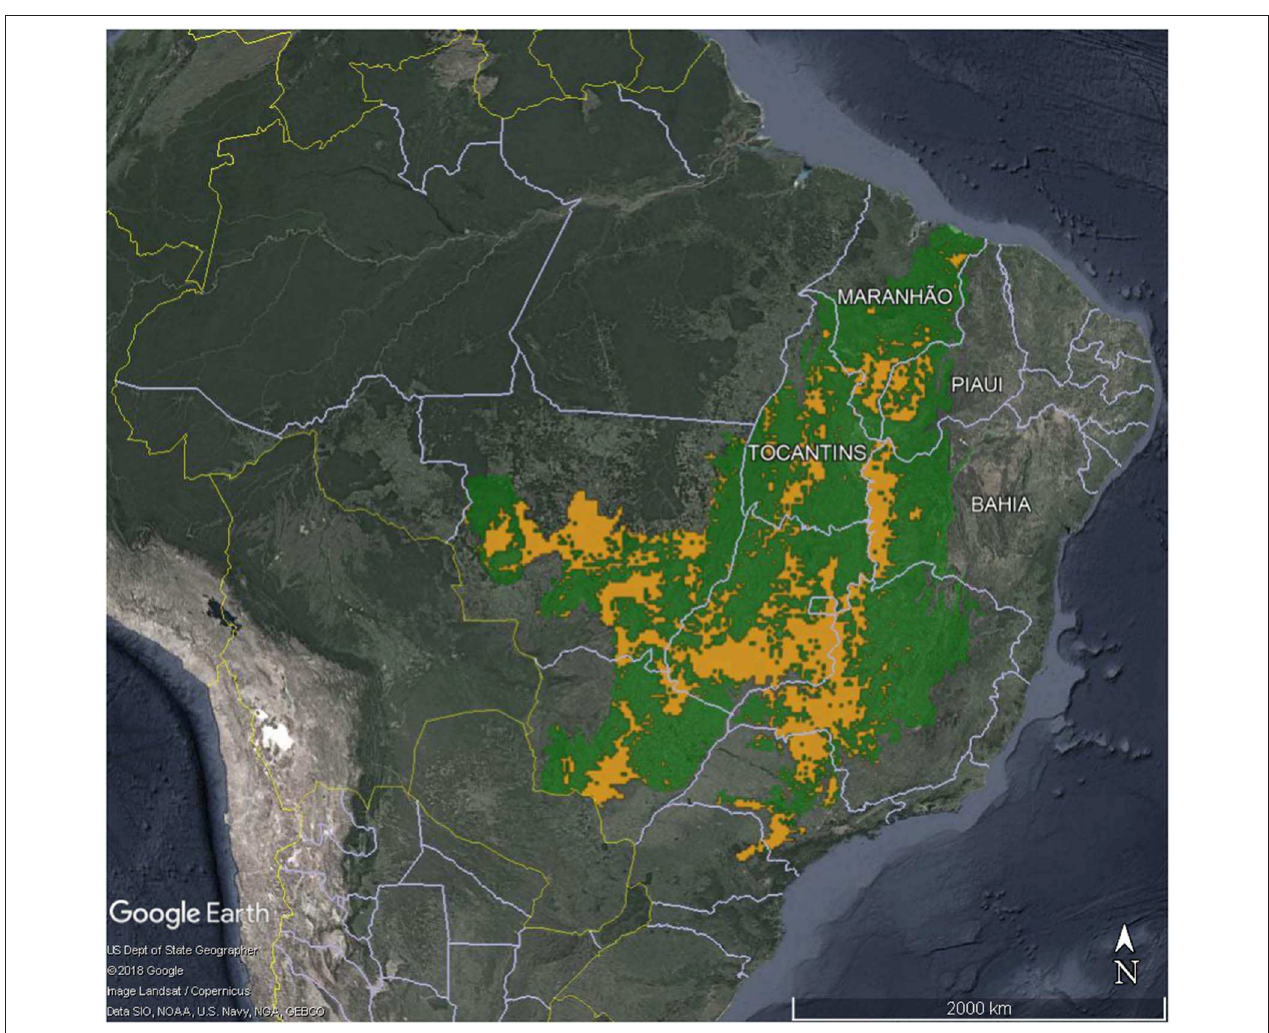
FIGURE 1 | Map of Brazil showing the Cerrado biome (shaded in green) and soy cultivation in the Cerrado (shaded in yellow; crop year 2013–2014) (Agrosatélite, 2019 ). The states making up the Matopiba soy frontier in the Cerrado are also marked.